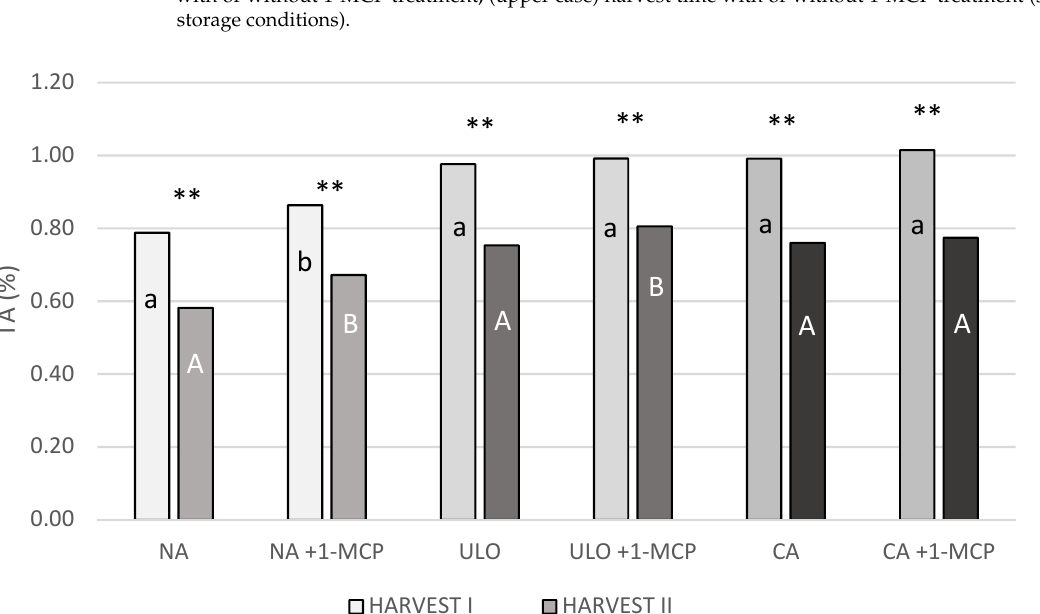
Figure 5. Titratable acidity of ‘Geneva’ fruit (%) depending on harvest time and 1-MCP treatment under three storage technologies. Statistically significant difference between first and second harvest fruit (Newman–Keuls range test): **—for 1%. Different letters were assigned to statistically significant differences when comparing the effect of 1-MCP, separately for storage conditions.